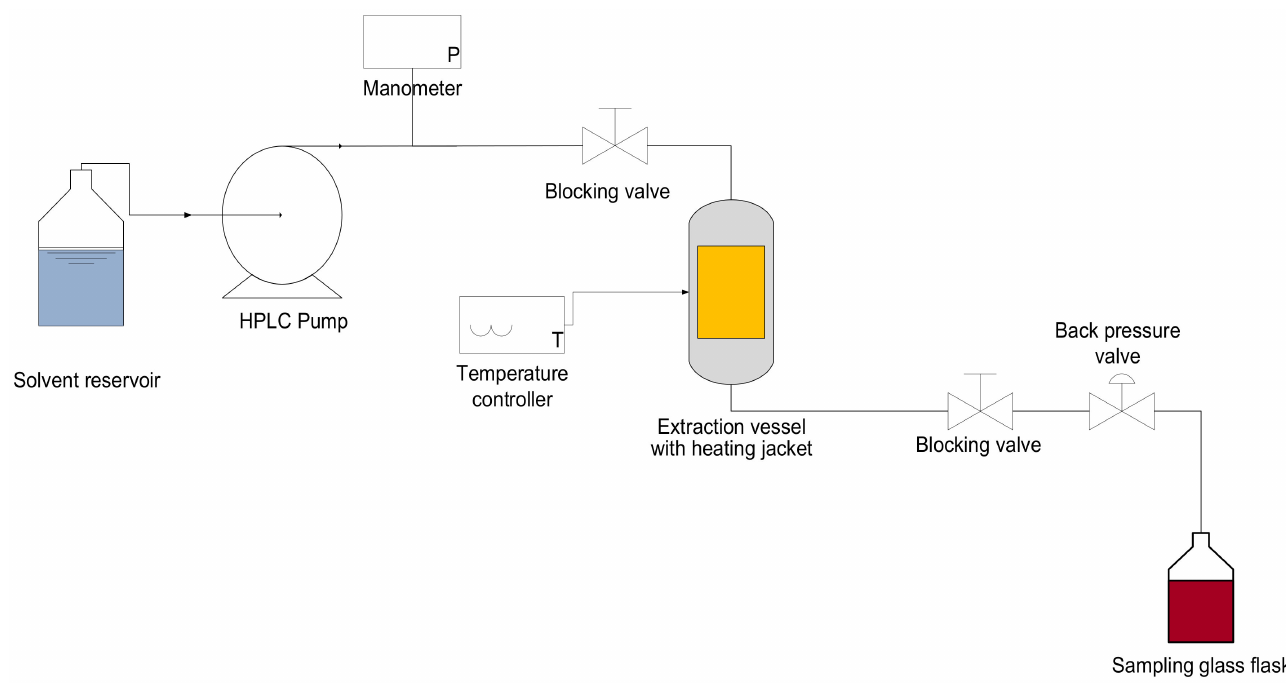
Figure 1. Schematic diagram of the homemade PLE